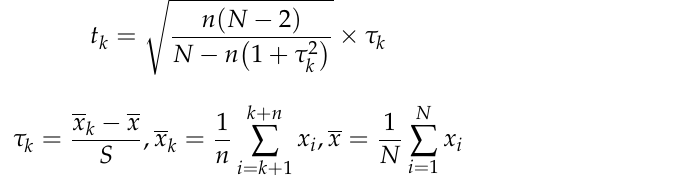
0 and the 20 cm pan